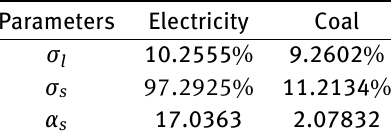
Table 1: Parameters of the two-factor model for electricity and